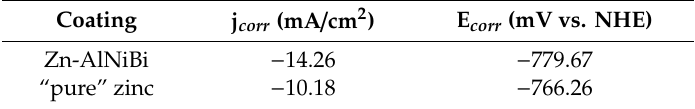
Table 5. Corrosion parameter values determined from polarization